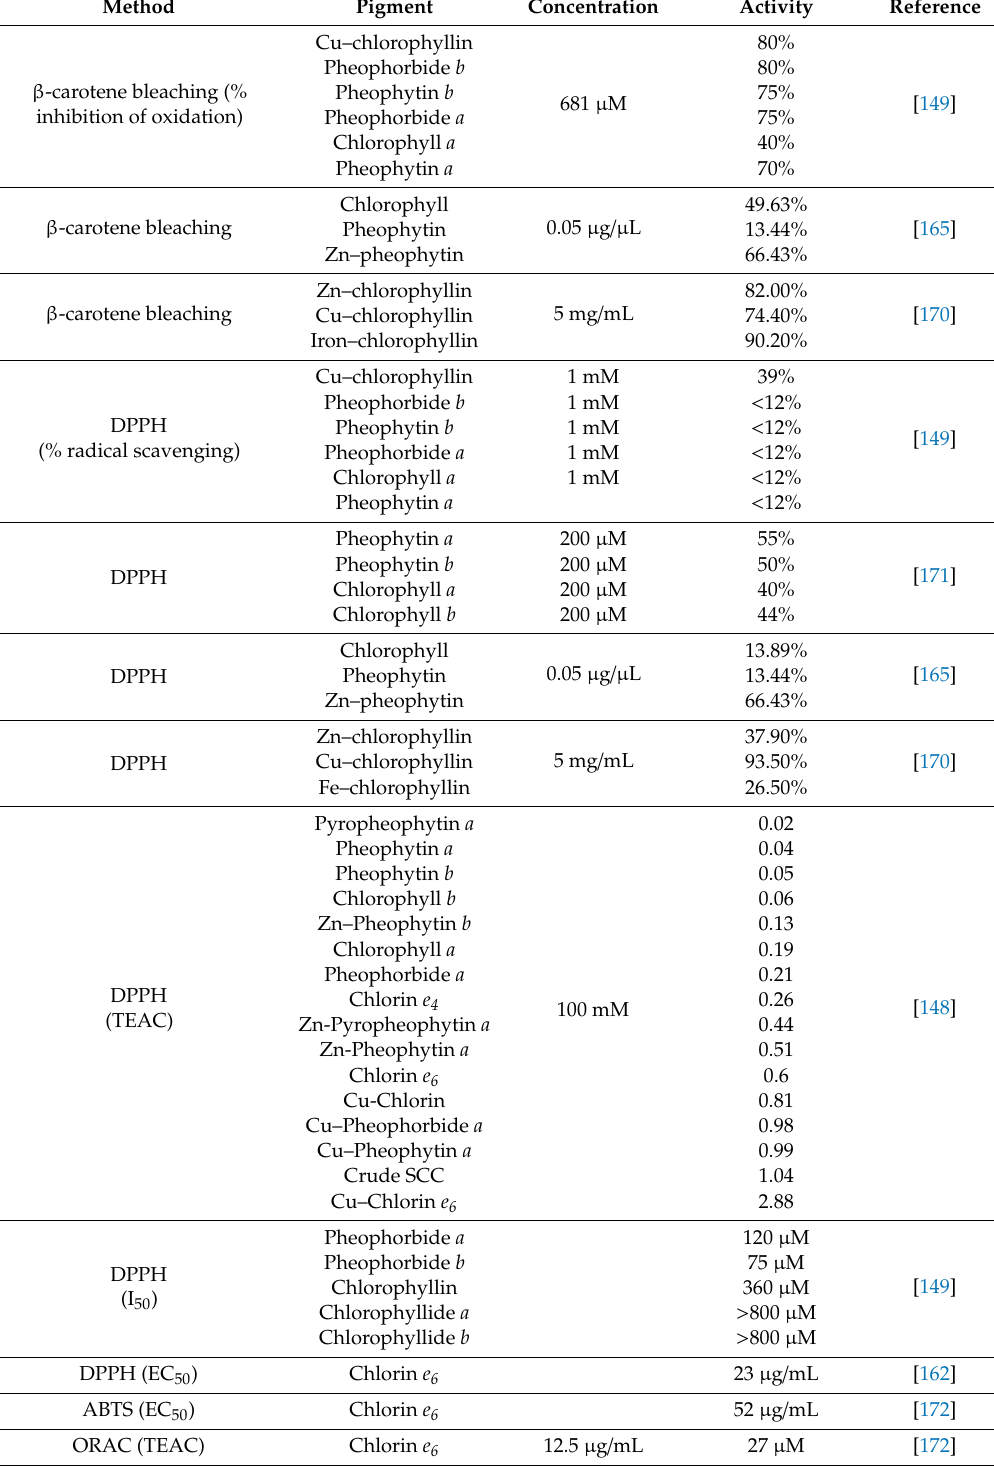
Table 6. Review of in vitro antioxidant activity measured for di ff erent free